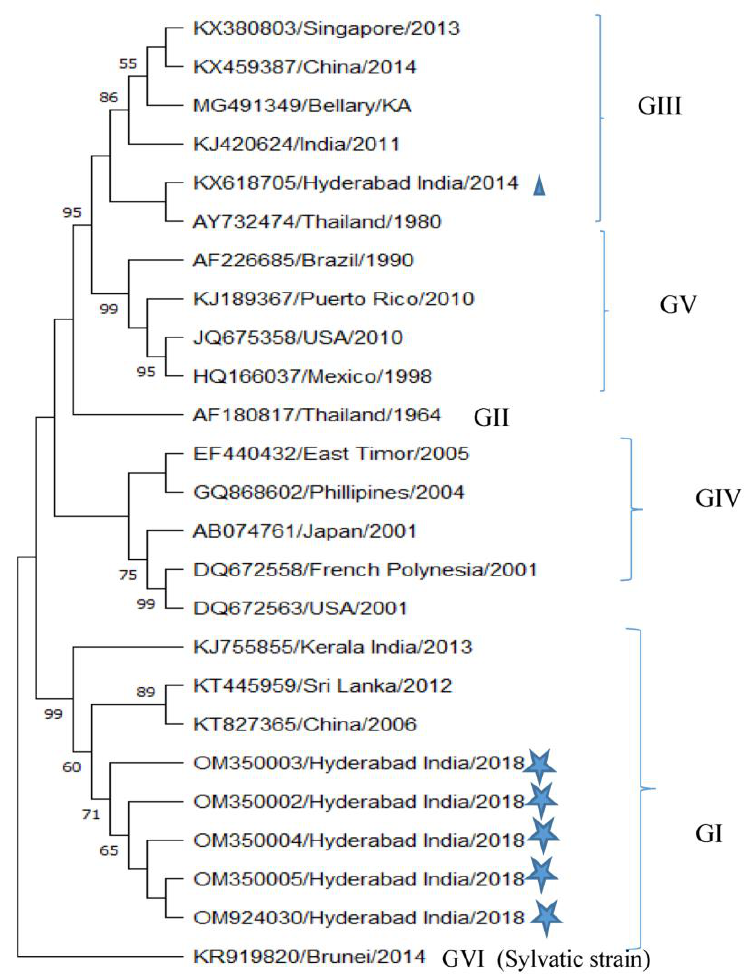
Figure 2. Phylogenetic tree of DENV-1 based on CpRM sequence generated by general time reversible model as described in the methods. The study sequences are marked by the symbol, which are clustered in GI (Asian genotype). Previous GIII (sylvatic strain) is also indicated by the symbol. The sequences are indicated by their accession number, country, and year of collection.